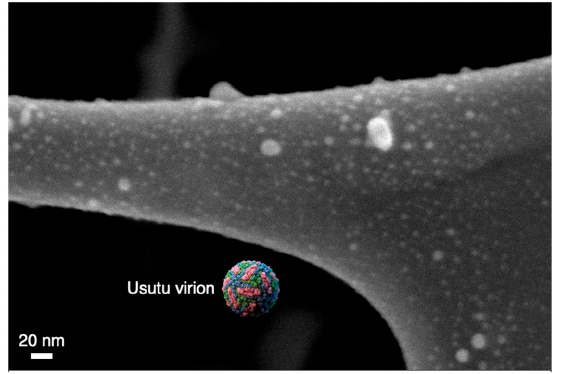
Figure 6. SEM image of Ag nanoparticles on a lacy carbon TEM grid . High-magnification SEM im- age of a 5-min deposit on a lacy carbon TEM grid showing that the majority of the coating is indi- vidual nanoparticles.